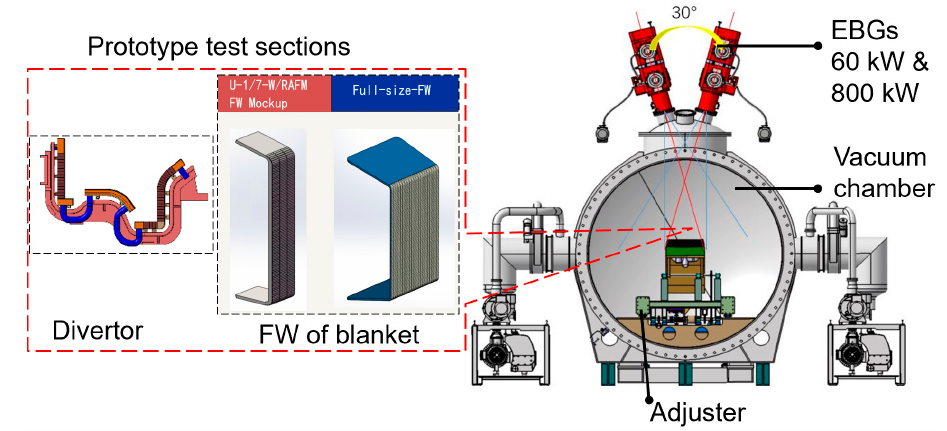
Figure 4. Schematic view of the one-side thermal radiation by EBGs.